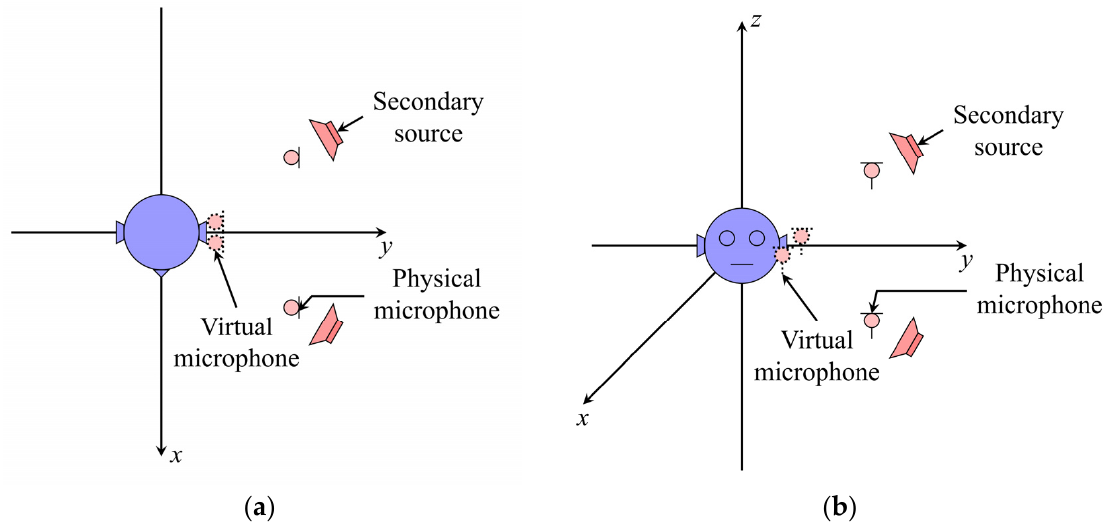
Figure 4. Dual-channel active headrest system: ( a ) layout A (top view); ( b ) layout B (front view). Since active headrest systems are generally used at low frequencies, simulations are carried out in a tonal sound field in this paper, with the tonal frequencies of 125, 250